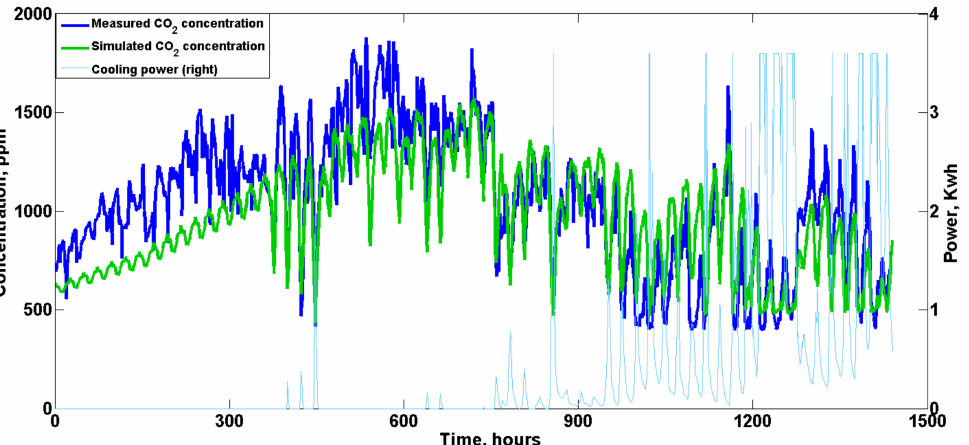
Figure 13. Measured and simulated indoor CO 2 concentrations during the validation test. Note: The base ventilation is not included in the figure. The maximum rated power of tunnel ventilation was 3.6